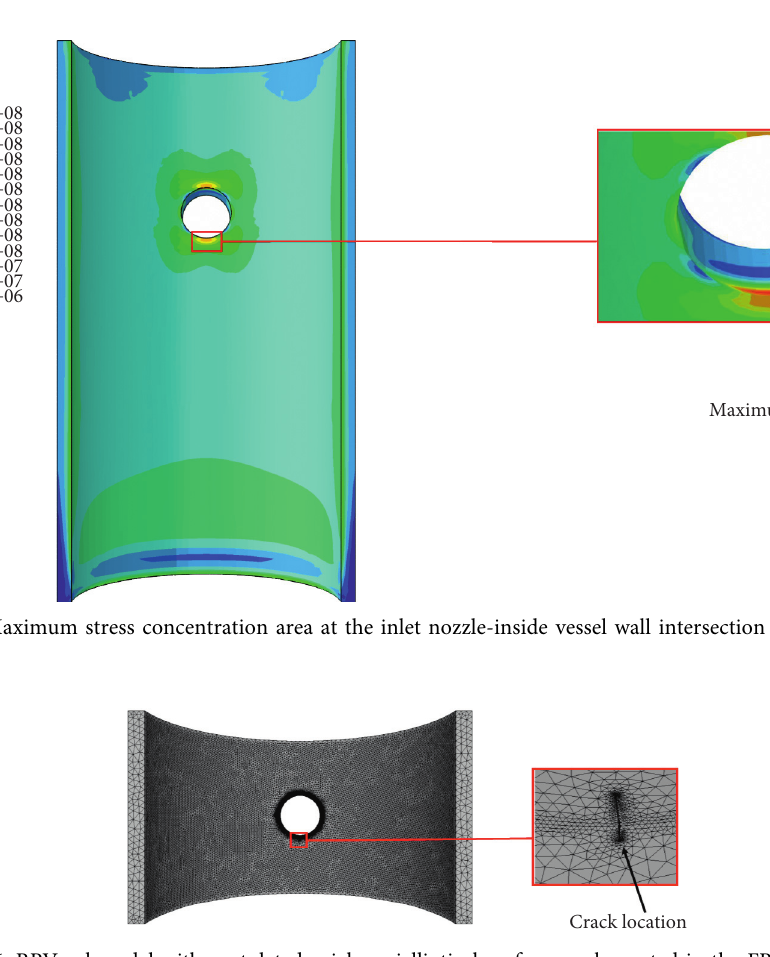
Figure 6: RPV submodel with postulated axial semielliptical surface crack created in the FRANC3D tool.